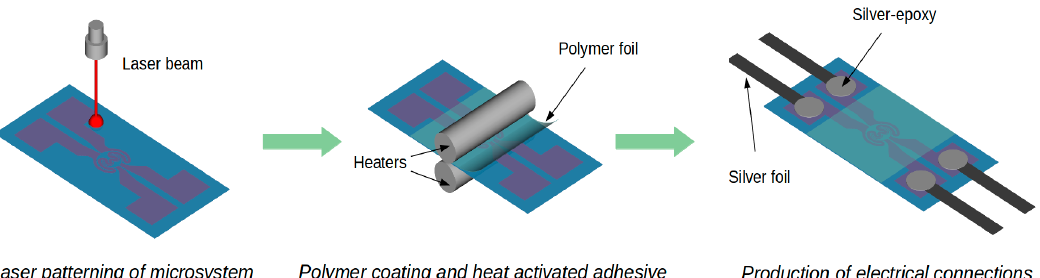
Figure 2. Preparation of heater-sensor structures.